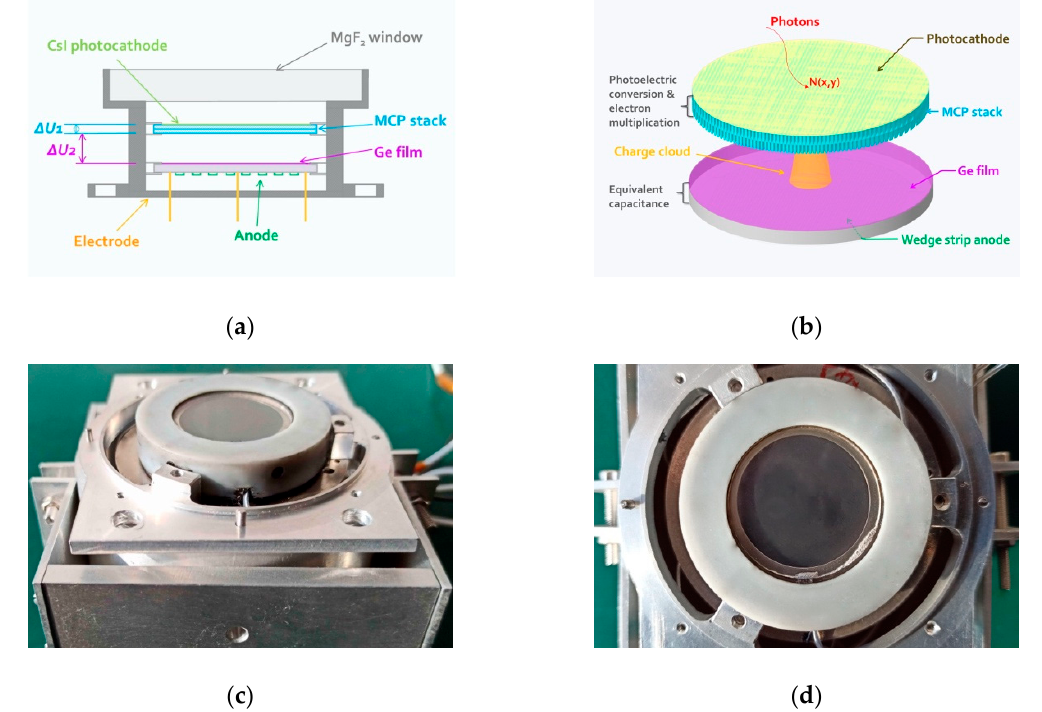
Figure 1. Schematic diagram and photograph of the FUV imaging detector. ( a ) Components and structure of the detector. A photoelectron is converted from a photon through the photocathode with CsI. Then, the photoelectron enters a pore of the MCP and collides with the wall to produce secondary electrons. A potential of Δ U 1 across the two MCPs accelerates these electrons through angled capillaries, producing an electron cloud. A final potential of Δ U 2 guides this electron cloud to the germanium film for readouts. Here, Δ U 1 and Δ U 2 indicate the applied voltage differences from the high-voltage divider. ( b ) Schematic of the detector with induction readout mode. The electron cloud emanating from the MCPs can be coupled to the anode through the equivalent capacitance and finally is released through the germanium film. ( c , d ) Photographs of the FUV imaging detector with a wedge strip anode. In addition to providing a vacuum environment for the function of the MCPs, the enclosed cavity acts as an electromagnetic shield.